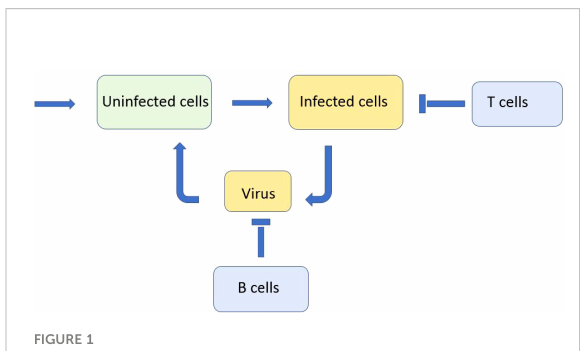
FIGURE 1 Schematic representation of a simpli fi ed model of infection progression and immune response. Virus replicates in infected cells and infects uninfected cells. Infected cells are eliminated by cytotoxic T lymphocytes and virus is neutralised by antibodies produced by B